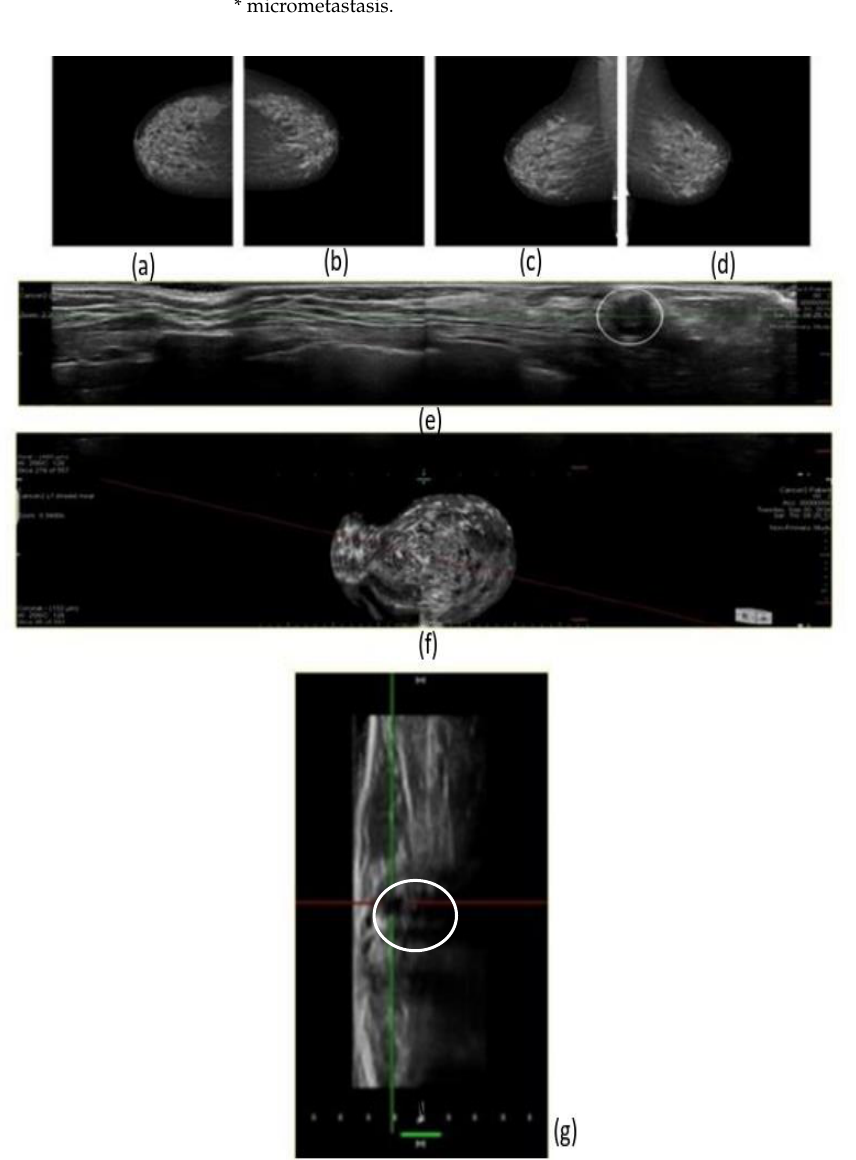
Figure 3. 3D Prone ABUS Images of ductal invasive cancer which was not visible on dense breast mammography. ( a ) Full field digital right craniocaudal breast mammography. ( b ) Full field digital left craniocaudal breast mammography. ( c ) Full field digital right mediolateral-oblique breast mammography. ( d ) Full field digital left mediolateral-oblique breast mammography. ( e ) 3D Prone ABUS right breast transversal plane image showing node negative invasive ductal cancer (white circle). ( f ) 3D Prone ABUS right coronal plane reconstruction. ( g ) 3D Prone ABUS Sagittal plane reconstruction cancer image circumscribed by perpendicular plane